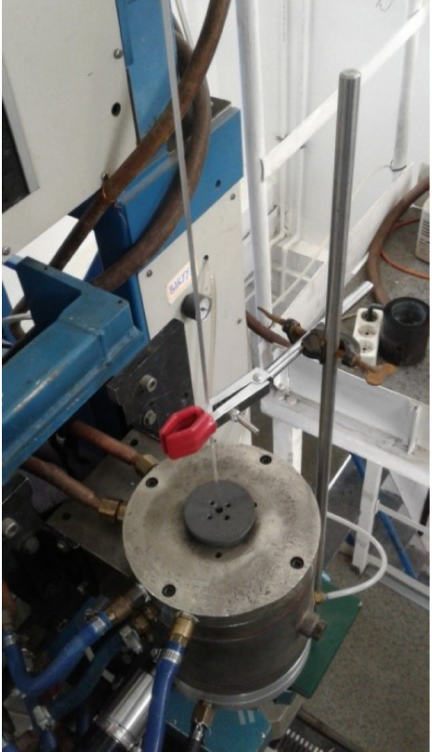
Figure 3. Special device for additional fixing of MOF cane to prevent its strong vibrations under a rotation speed of more than 300 revolutions per